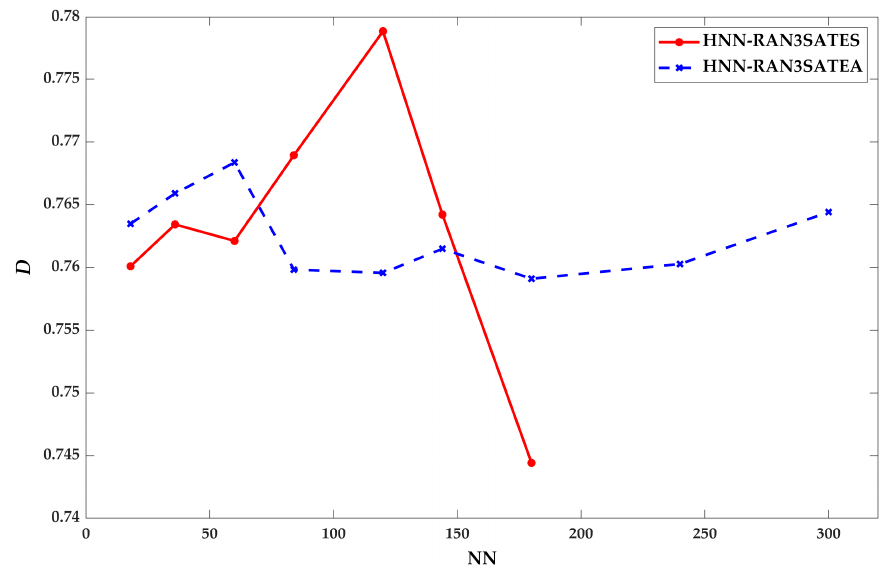
Figure 12. D (Dice) for HNN-RAN3SAT model.